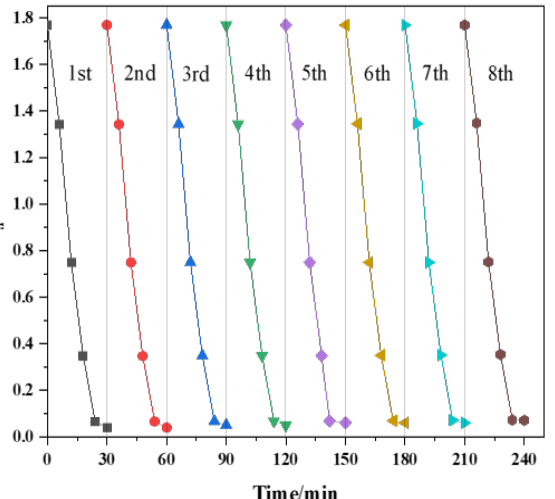
Figure 6. Reusability experiments of the NiFe 2 O 4 system (Reaction conditions: PS concentration = 0.4 g/L, catalyst dosage = 0.6 g/L, reaction temperature = 25 °C, phenol concentration = 0.01 g/L and initial pH value = 6.5 (unadjusted)).